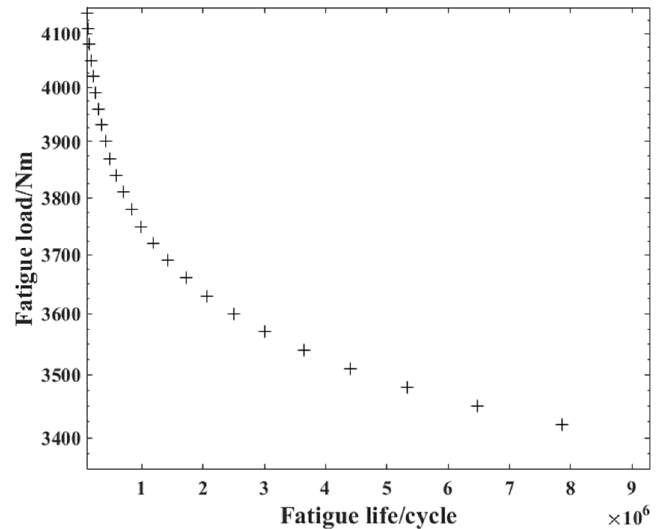
Figure 12. The load-life relationship of crankshaft N0.